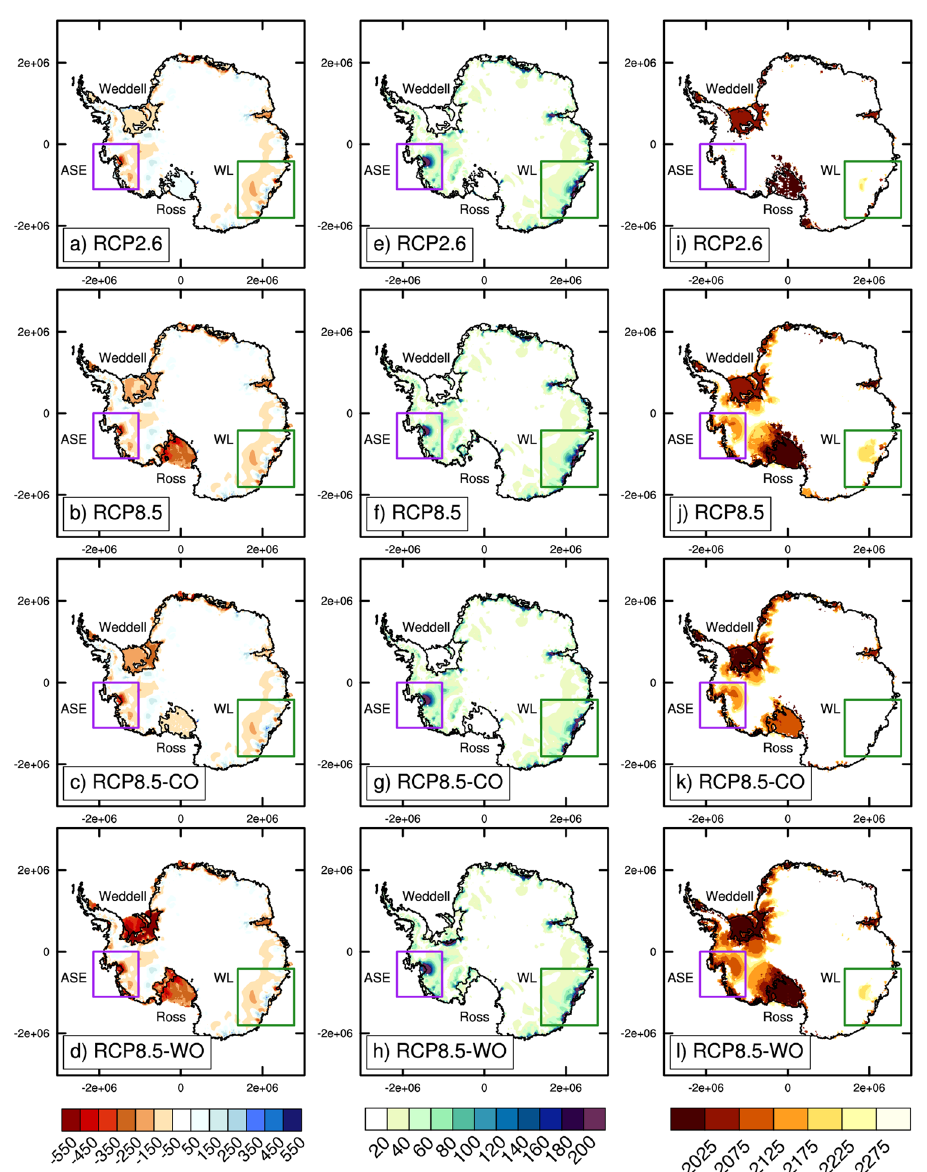
Fig. 2 Modeled ice thickness changes and threshold exceedance. a – d Ice thickness change (m) for the period of 2015 – 2100 for the RCP2.6, RCP8.5, RCP8.5-CO, and RCP.85-WO ensemble averages. e – h Ice thickness standard deviation at 2100. i – l Time when the difference between the scenario-based ensemble average and a control (constant climate) ensemble average exceeds the standard deviation of the control ensemble. ASE and WL refer to the Amundsen Sea Embayment and Wilkes Land,